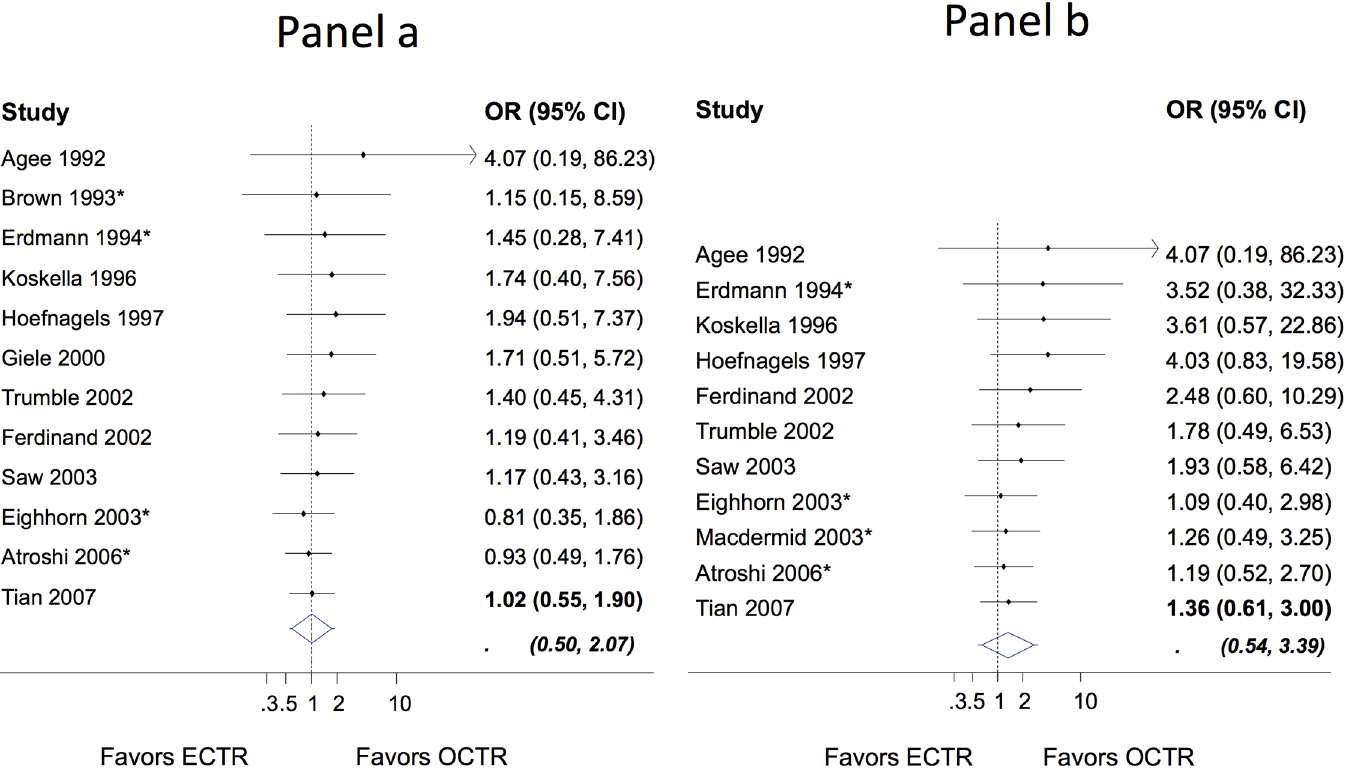
Fig 2. Cumulative odds ratios (OR) and 95% confidence interval (CI) for recurrence (panel a) and reoperations (panel b). The extended lines outside the diamond in the final meta-analytic summary shows the 95% prediction intervals. Asterisk indicates that the study has used a two-portal ECTR.